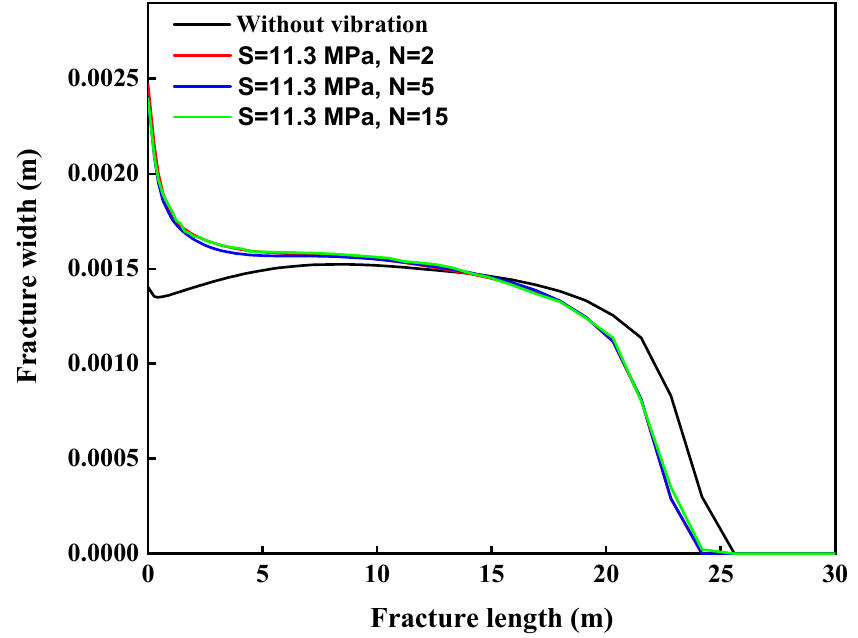
Figure 10. Fracture width versus fracture length for constant cyclic load magnitude and different number of cyclic loads aft the final stage of simulation ( t = 100 s).